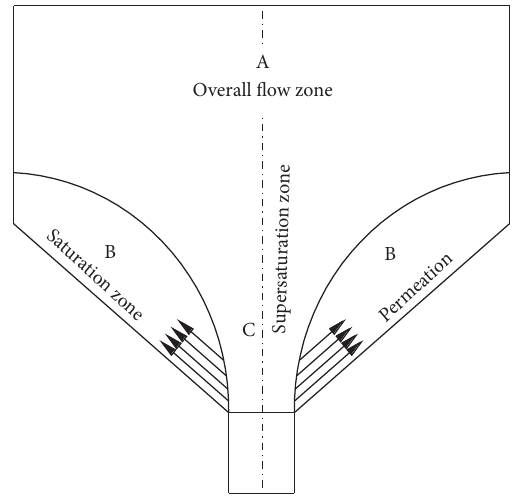
Figure 1: Flow part during deep cone thickener discharging